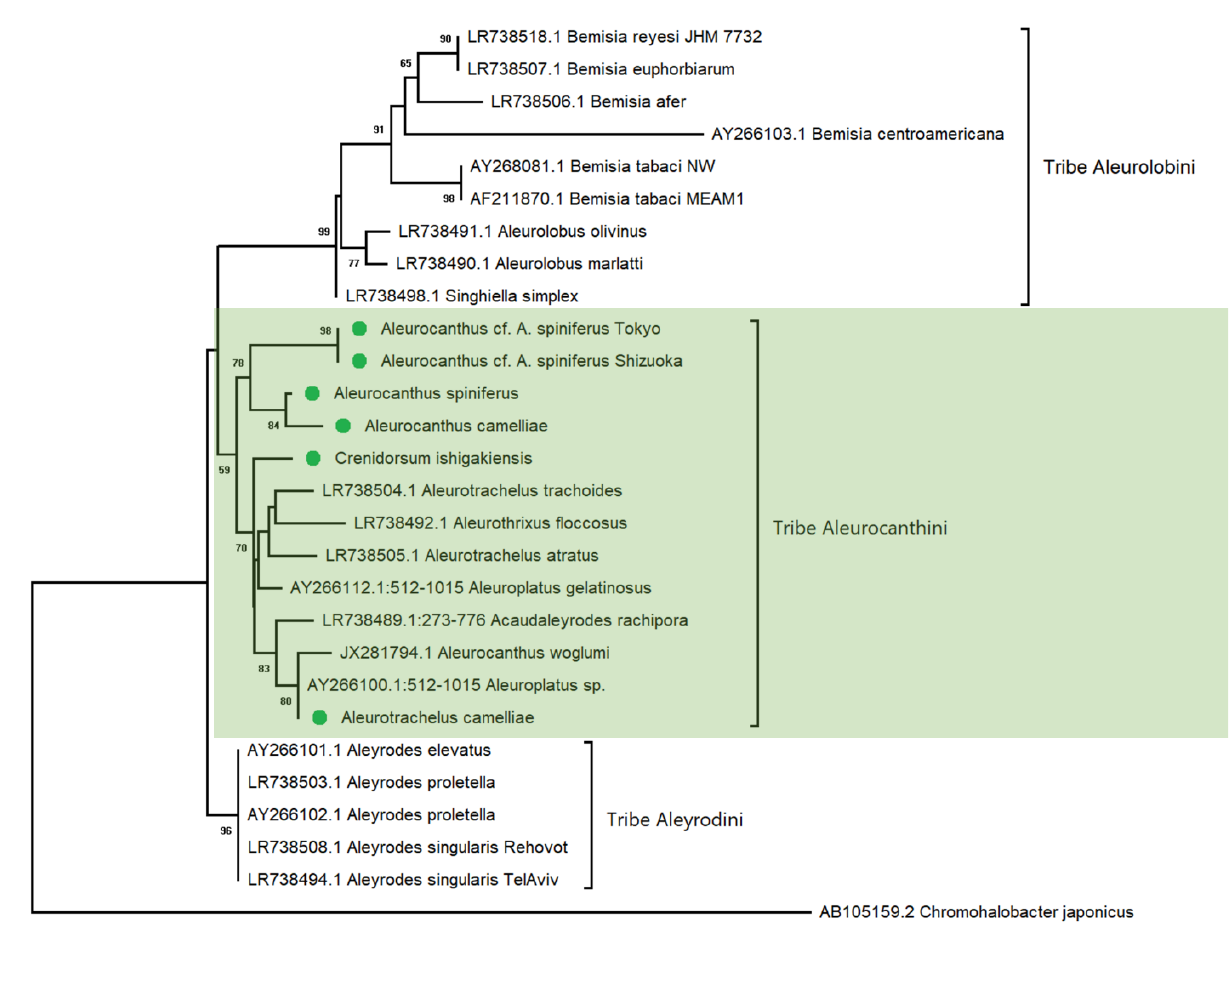
sequence of Nilaparvata lugens (No. FJ810191) was placed as an out-group. The green circles are the samples examined. Alignment length 416 bp. Note: identical sequences of Crenidorsum turpiniae